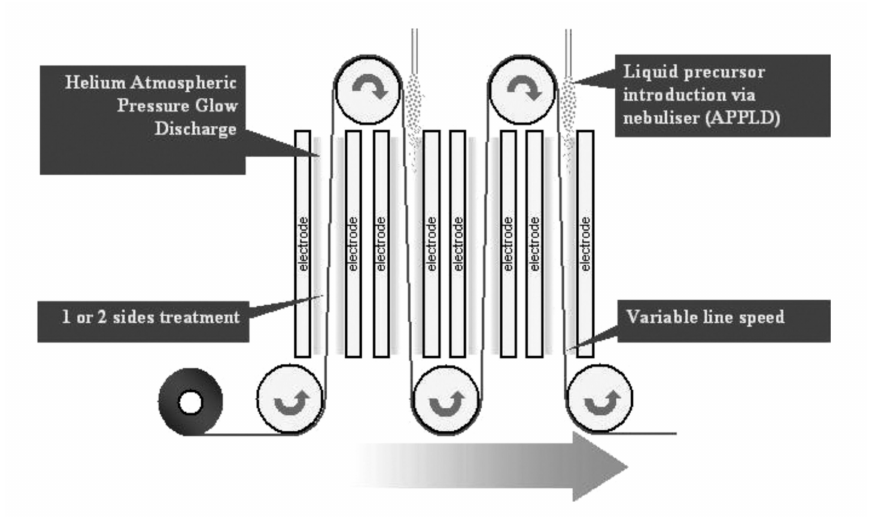
Figure 14. Schematic representation of the roll-to-roll APP reactor for the deposition of composite antibacterial coatings. Reprinted with permission from [35]. Copyright 2006 John Wiley & Sons,